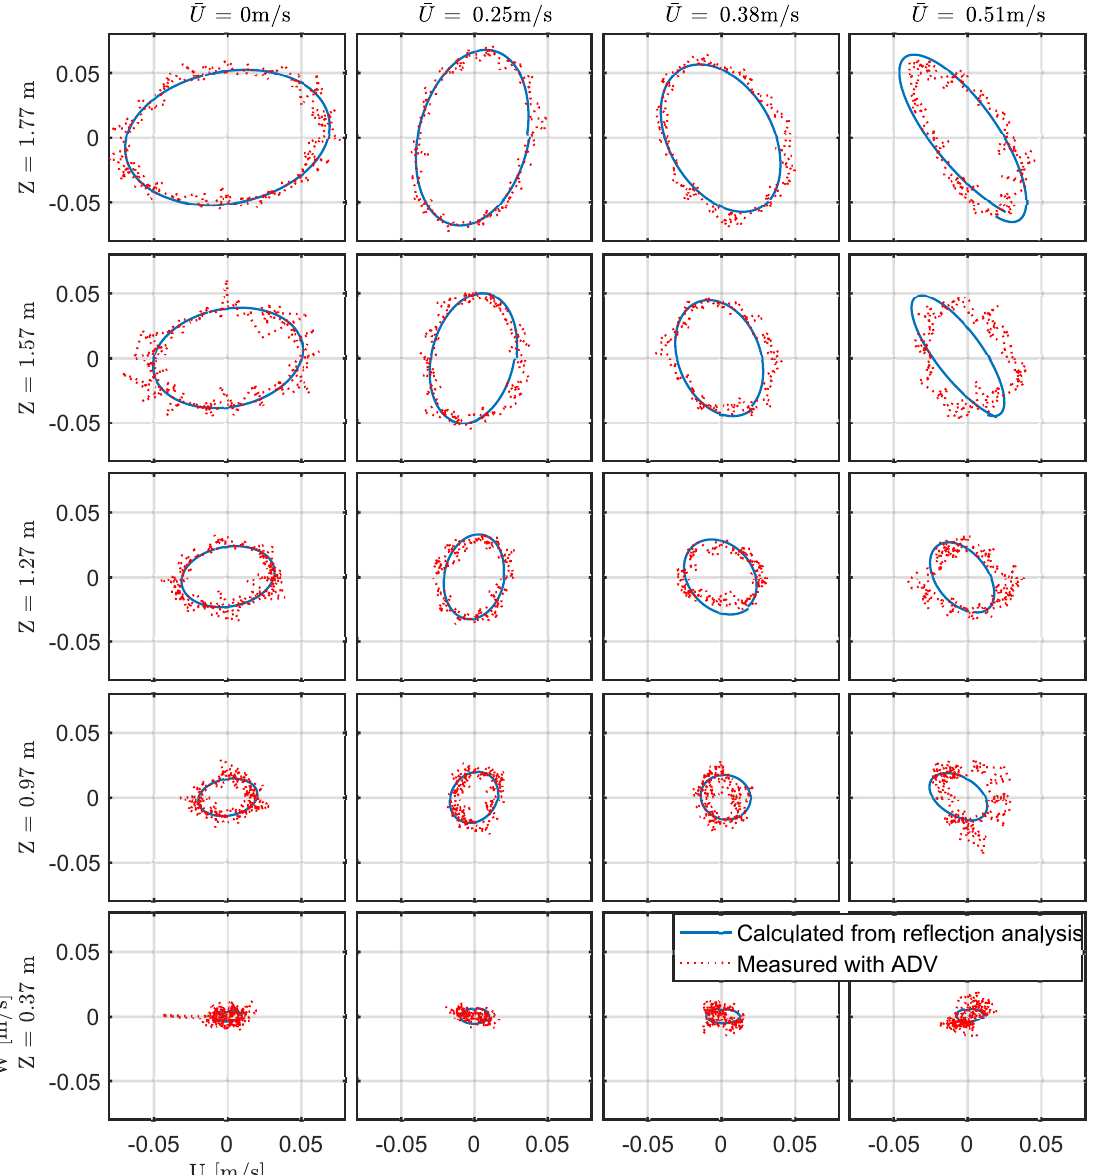
Figure 15. Measured wave orbitals ( U vs. W time series) compared with those expected from theory. Shown for regular wave cases (Sea States 1–4, Table 3) for each of the five ADV